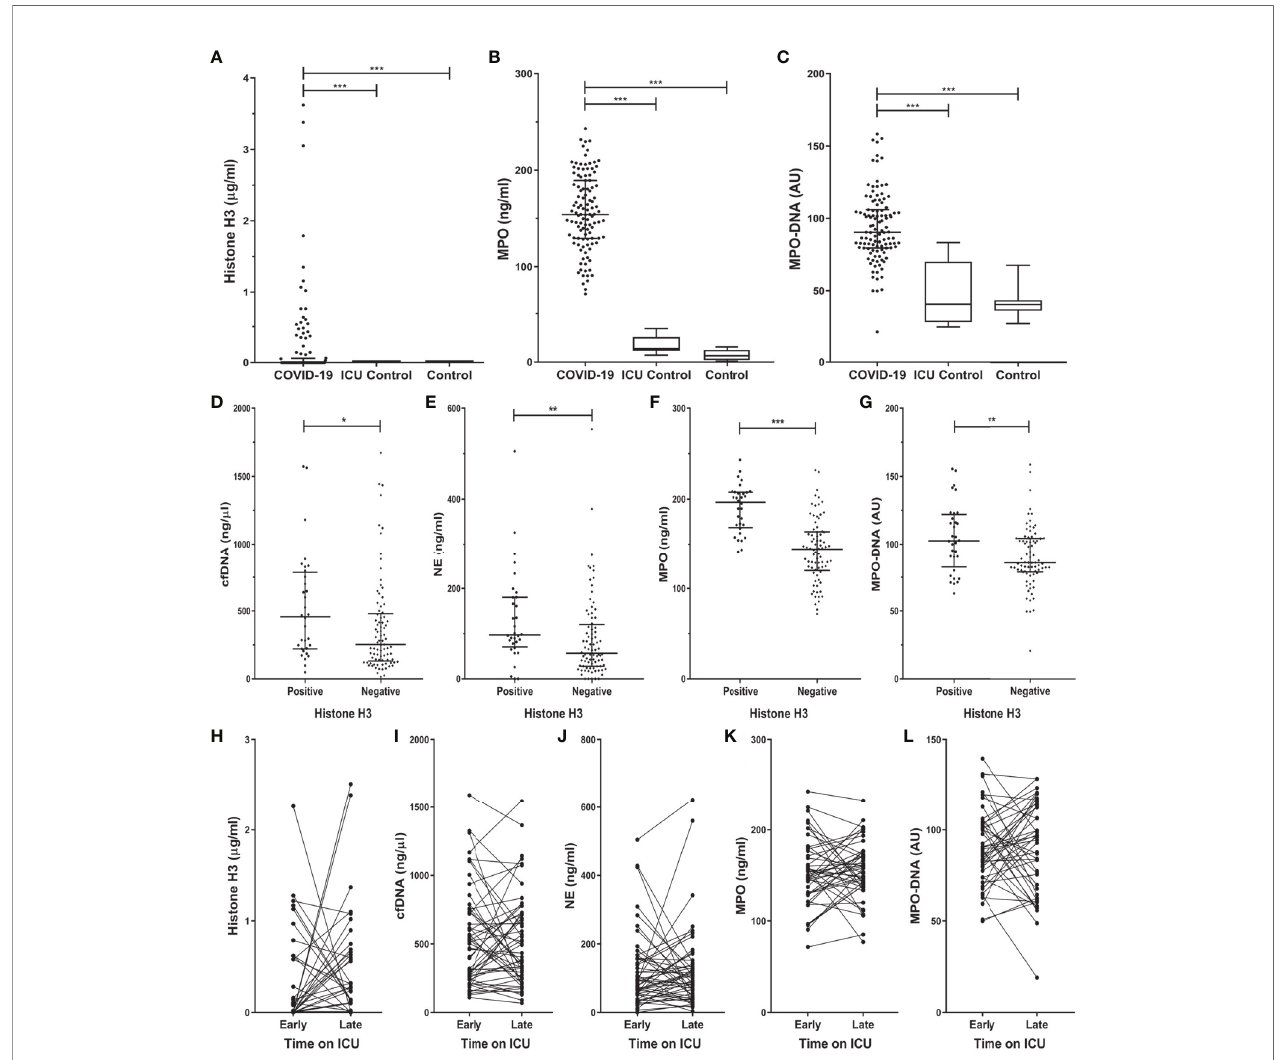
FIGURE 1 | Histone H3 and NET components increased in COVID-19 ICU patients on admission (A – C) , are increased in COVID-19 histone H3 positive patients (D – G) and subsequent stay (H – L) at the ICU department. Plasma from COVID-19 (n=117), non-COVID-19 ICU patients (n=11), and healthy control (n=15) was tested for the presence, represented as median (IQR) or box and whisker plot, of histone H3 (A) , myeloperoxidase (MPO) (B) , and the MPO-DNA complex (C) . COVID-19 samples were compared to control groups with the Kruskal-Wallis test with Dunn ’ s post-hoc test. The level of cfDNA (D) , NE (E) , MPO (F) , MPO-DNA (G) in the COVID-19 histone H3 positive and negative groups. Samples were compared by Mann-Whitney U test. The level of histone H3 (H) , cfDNA (I) , NE (J) , MPO (K) , and MPO-DNA (L) of a subset of COVID-19 patients were followed in time on early (1-3) and late ( ≥ 4) days at the ICU department. Samples Early-Late were compared by Wilcoxon matched-pairs signed-rank test. P-values were considered signi fi cant if p < 0.05; *0.05, **0.01,